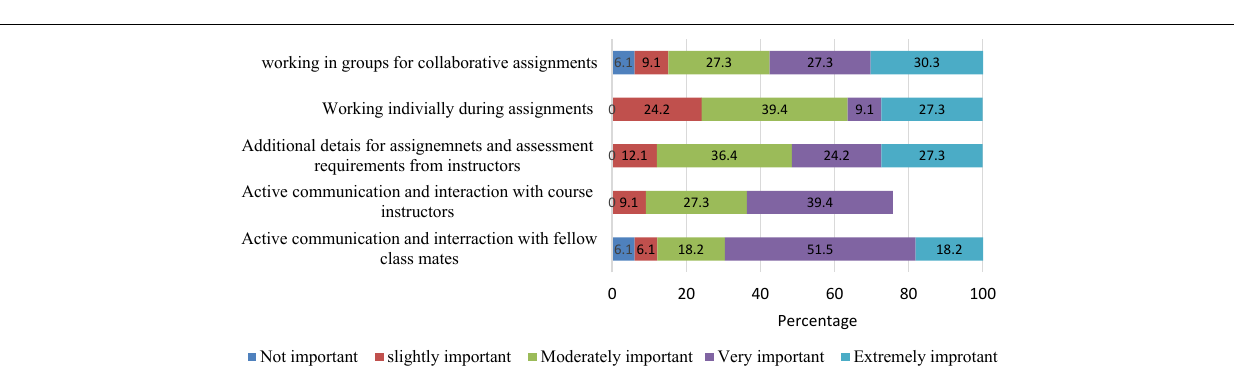
FIGURE 3 | Students’ opinions about varied forms of interaction with peers and instructors.